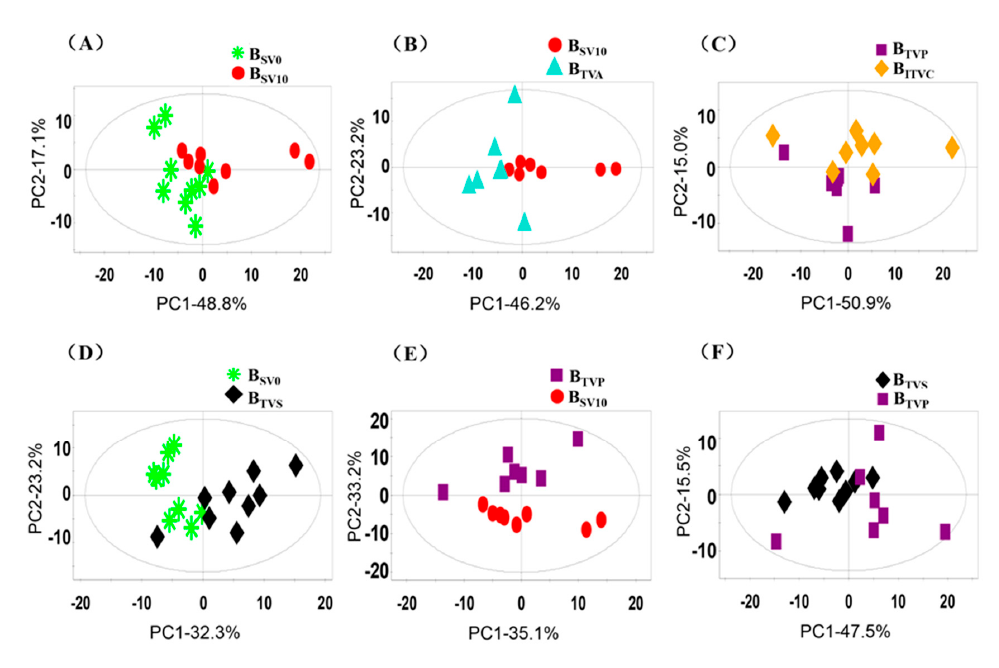
Figure 6. Loading plots of principal component analysis (PCA) of the NMR spectral data from various blood samples. Note: Every sample is represented by a unique pattern. Note: A : B SV0 vs B SV10 ; B : B SV10 blood samples. Note: Every sample is represented by a unique pattern. Note: ( A ): B SV0 vs. B SV10 ; vs B TVA ; C : B IVP vs B ITVC ; D : B SV0 vs B TVS ; E : B TVP vs B SV10 ; F : B TVS vs B TVP . ( B ): B SV10 vs. B TVA ; ( C ): B IVP vs. B ITVC ; ( D ): B SV0 vs. B TVS ; ( E ): B TVP vs. B SV10 ; ( F ): B TVS vs. B TVP .